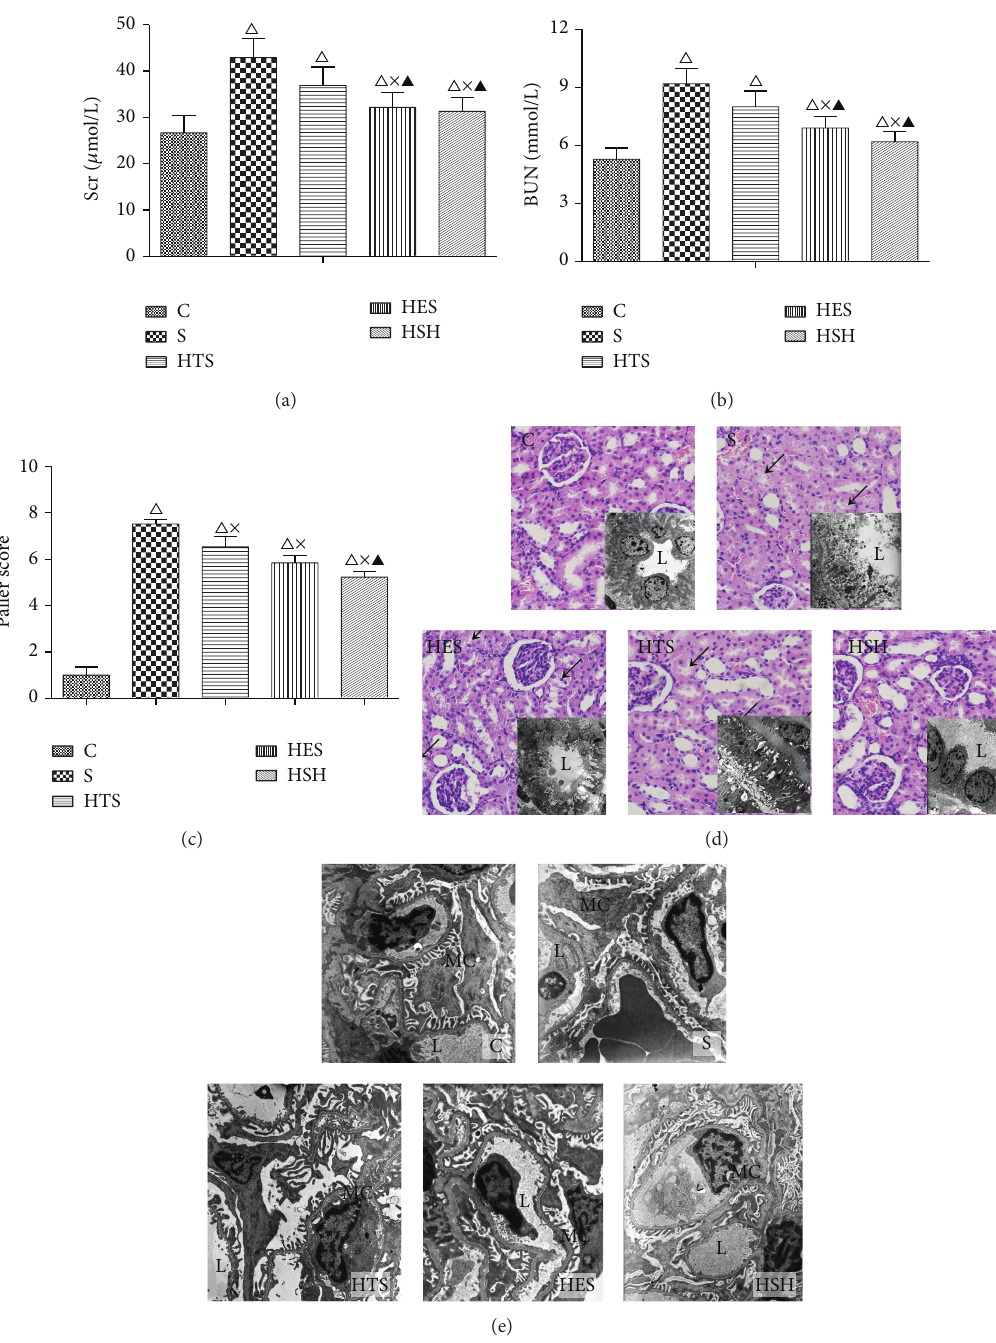
Figure 1: Small-volume resuscitation alleviated the severity of renal injury in rats with LPS-induced endotoxemia. (a) and (b) show alterations in renal function parameters in response to small-volume resuscitation with different solutions after LPS administration. (c) shows Paller scores in different groups. (d) Renal pathology changes under light (stained with HE, × 400) and electron microscopy (for tubular ultrastructure, × 2950).PhotomicrographshowsanintactepithelialsystemwithnormalrenaltubulesandglomeruliingroupC,whiletherenal tubule exhibited serious degeneration, disintegration, and edema in epithelial cells as well as cellular debris obstructing the collecting tubules in group S (as shown by ↙ ); HTS-treated group showed only local epithelial and mitochondrial edema with less necrosis and abscission, while the HES- and HSH-treated groups only showed occasional injury. Ultrastructure (L: lumen, EC: epithelial cells). (e) Ultrastructure of glomerulus under an electron microscope ( × 5200). Photomicrograph shows normal glomerular structure in group C, while the number of foot processes in podocytes decreased and these foot processes were locally confluent with small amounts of dense deposits inside the basement membrane in group S. However, the podocytes were restored to a normal state with no dense deposits in photomicrographs from the HTS-, HES-, and HSH-treated groups. (L: lumen; MC: mesangial cell; RC: red cell; WC: white cell). △ 𝑃 ≤ 0.05 compared to group C; × 𝑃 ≤ 0.05 compared to group S; 󳵳 𝑃 ≤ 0.05 compared to the HTS